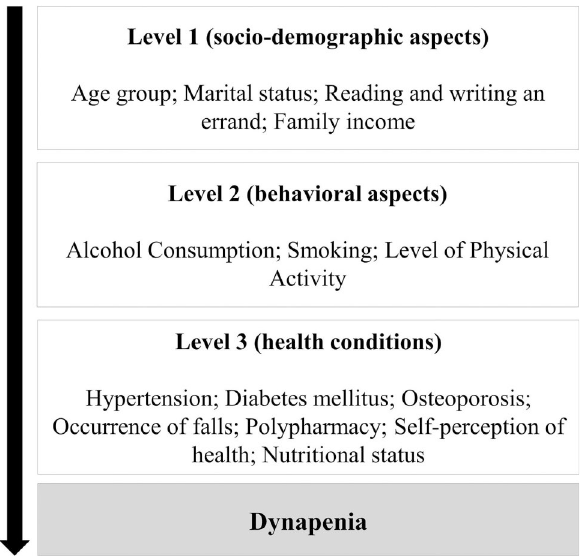
Figure 2 - The hierarchical model was used to identify factors associated with dynapenia in older women. Jequié-BA, Brazil,